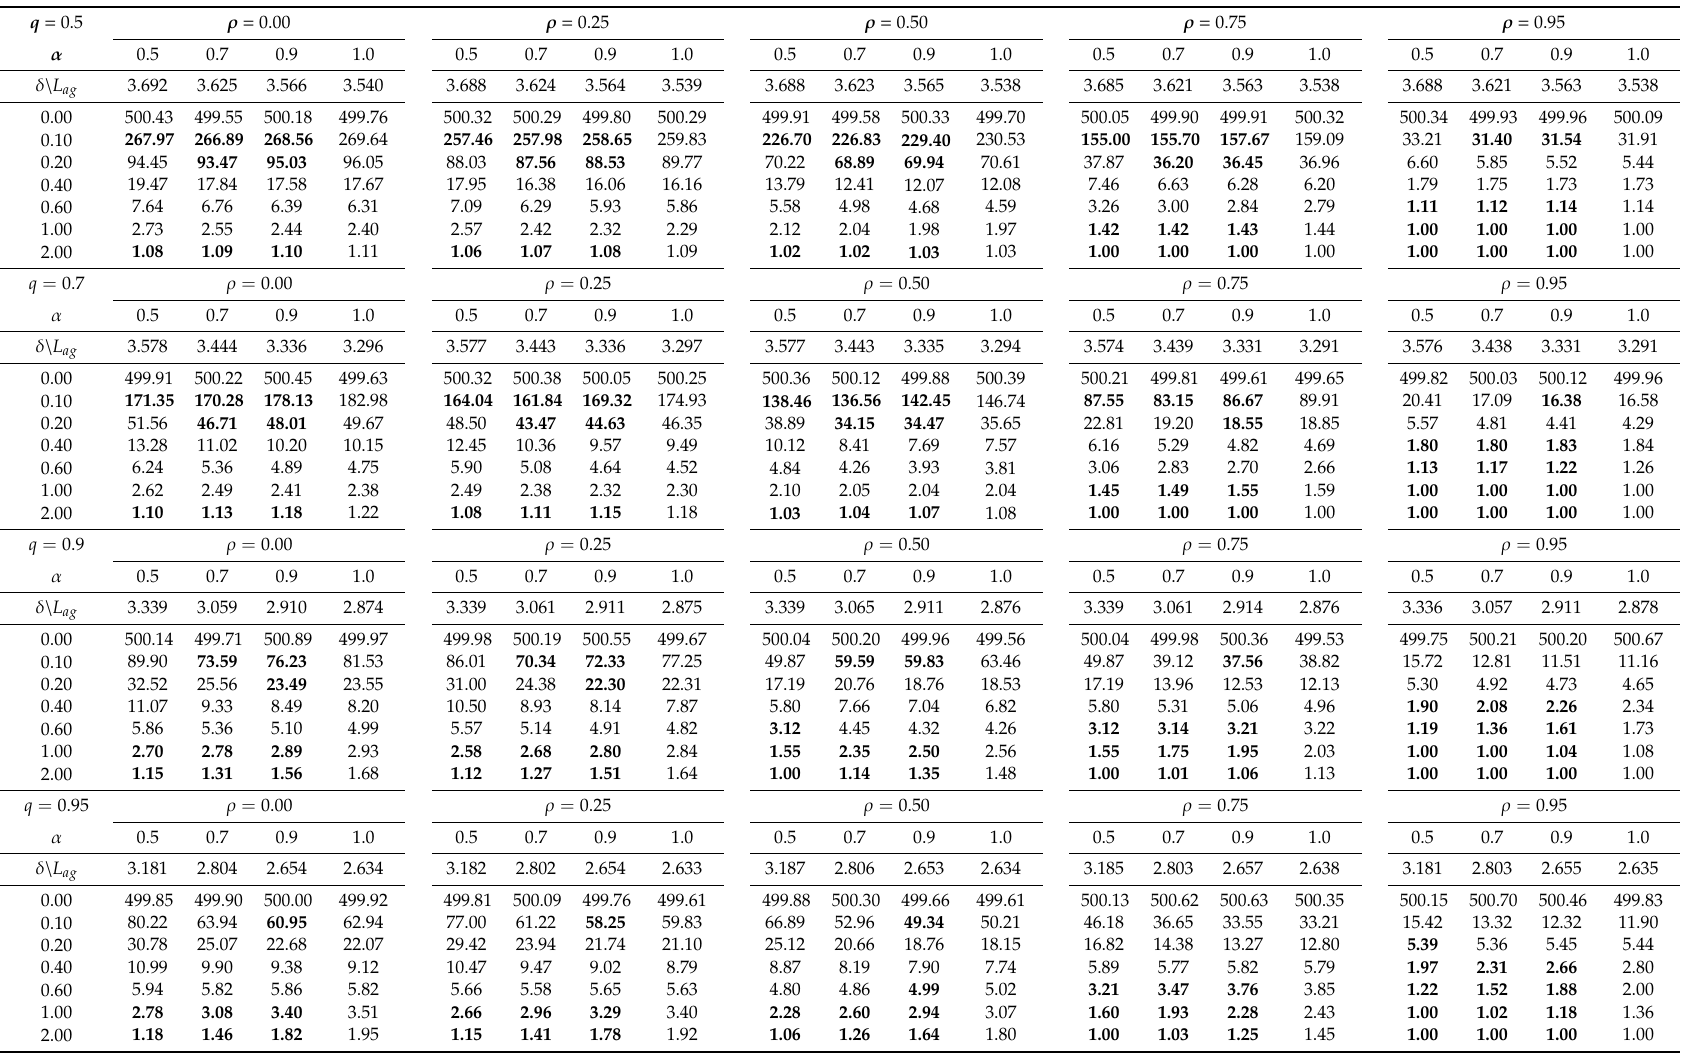
Table 3. Values for the AIB-GWMA-t charts when n =